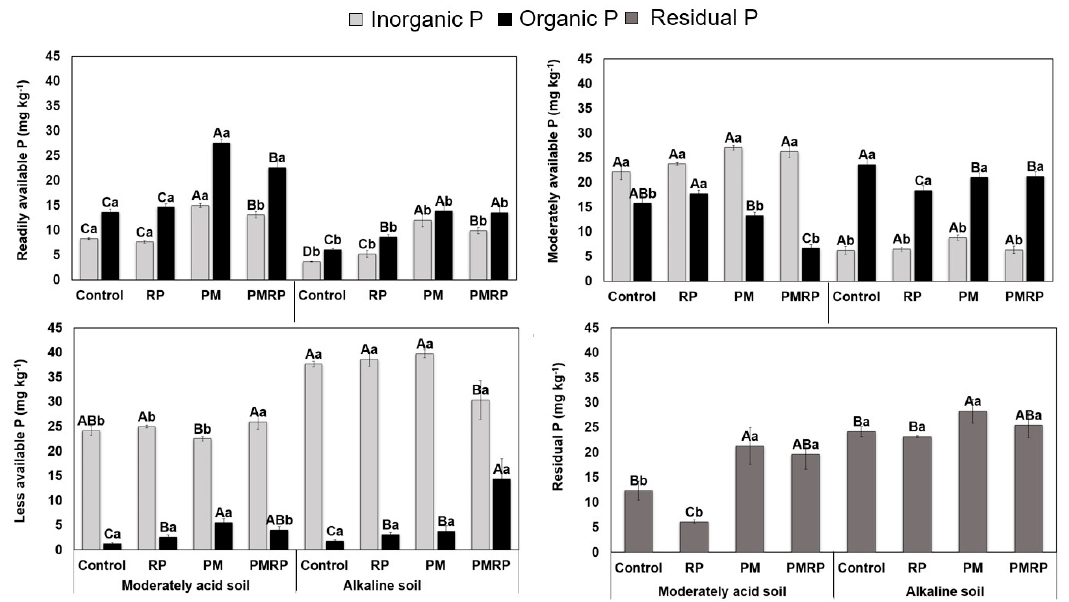
Figure 1. Inorganic and organic P concentration of fractions extracted from control and soil amended with poultry manure compost (PM), phosphate rock (RP), and their combination (PMRP) after 7 weeks of ryegrass growth. Upper case letters denote significant differences ( p ≤ 0.05) between treatments for one soil. Lower case letters denote significant differences ( p ≤ 0.05) between soils for one treatment.